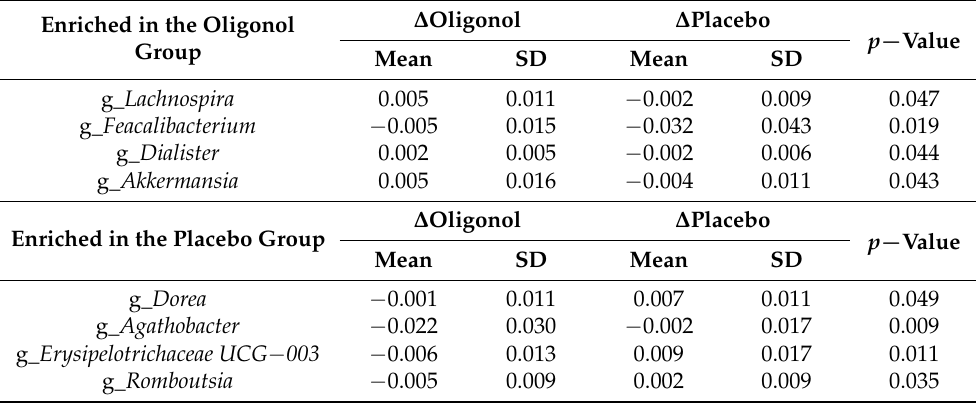
Table 3. Post- and pre-treatment significant changes ( ∆ ) of relative abundance at the genus level in the oligonol and placebo groups.